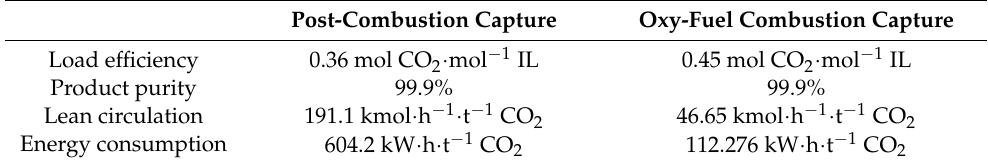
Table 6. Comparison between post-combustion capture and oxy-fuel combustion capture. Post-Combustion